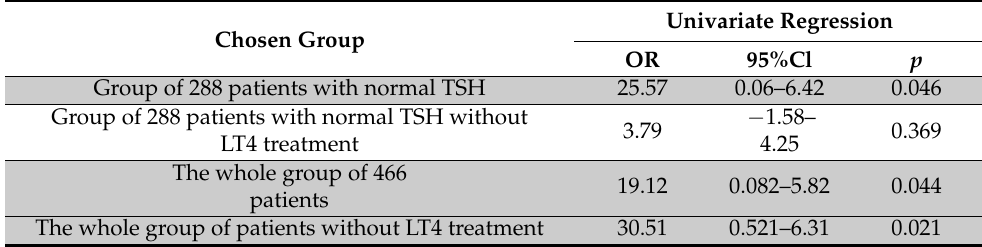
Table 8. Univariate logistic regression analysis of isolated hypothyroxinemia (IH) determinants performed in specified groups. Results are presented only for insulin resistance index (IRI). Chosen